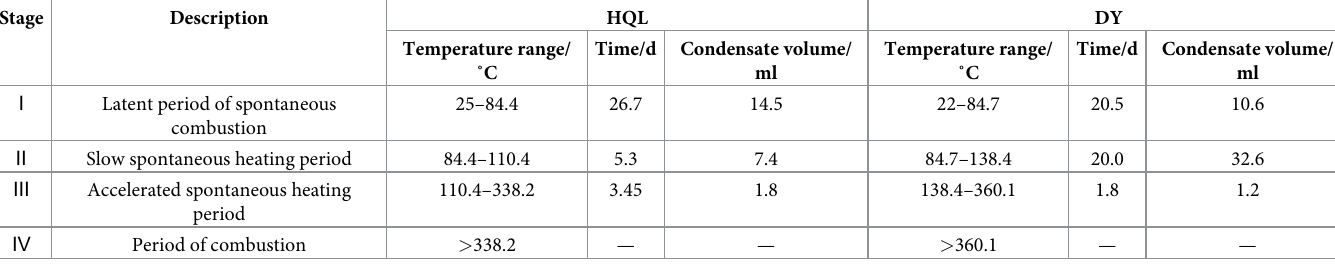
Table 4. Amount of condensed water precipitation during the upward trend of coal spontaneous